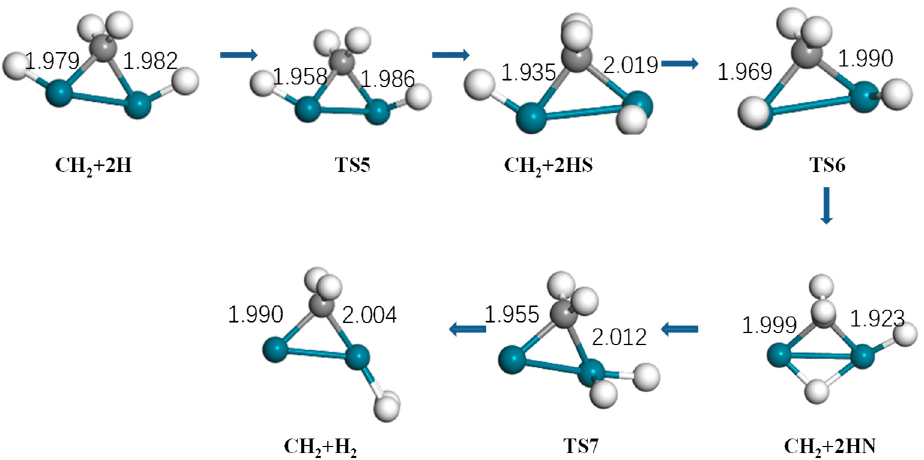
Figure 7. Optimized structure of reactants, intermediates, products, and the transition state of hydrogen generation by Pd 2 (turquoise: Pd, gray: C, white: H).